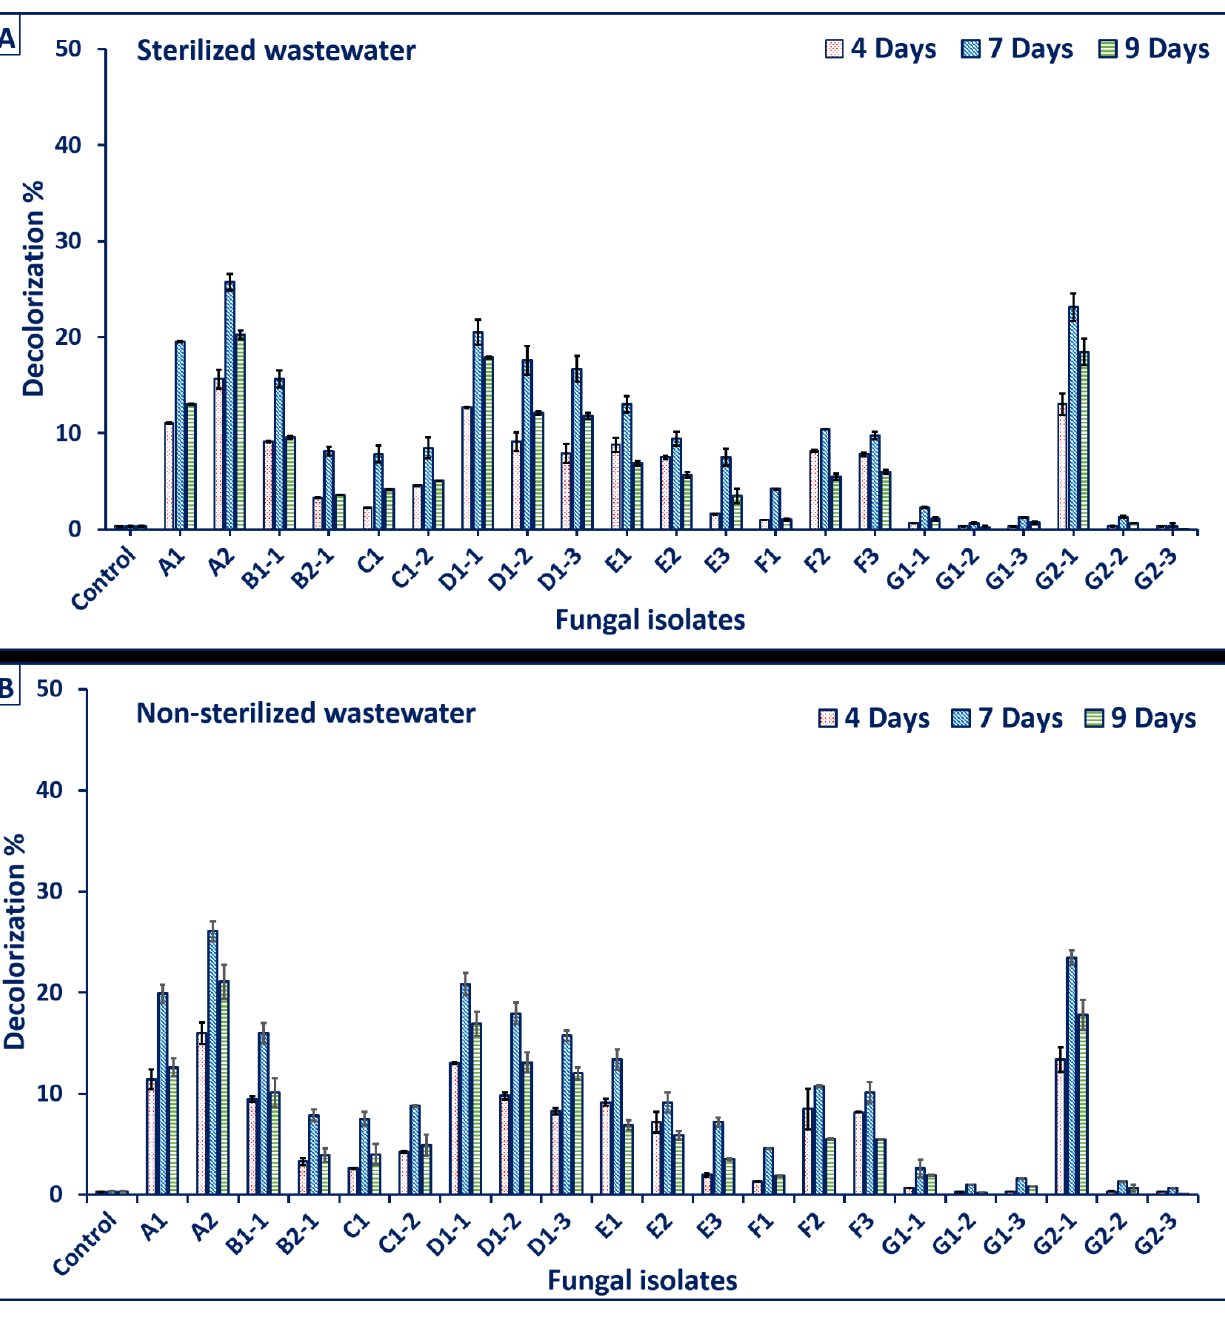
Figure 1. Assessment of the efficacy of isolated fungal strains to decolorization of textile wastewater under sterilized con- dition ( A ) and non-sterilized condition ( B ). See results for the identities of the fungal isolates tested in this study.